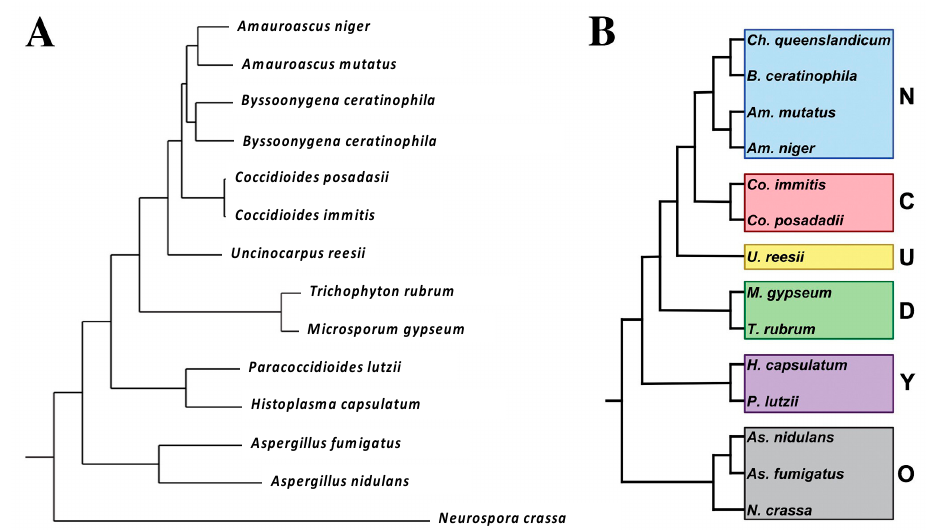
Figure 1. Phylogenetic distance tree (Bayesian) with posterior probabilities based on 100 randomly selected single-copy orthologs ( A ). Phylogenetic categories used for gene family expansion/contraction and ortholog group analysis ( B ). N, newly sequenced genomes. C, Coccidioides , U, U. reesii ; D, dermatophytes; Y, yeast-forming dimorphic fungal pathogens; O, outgroups. The figure is from [14].